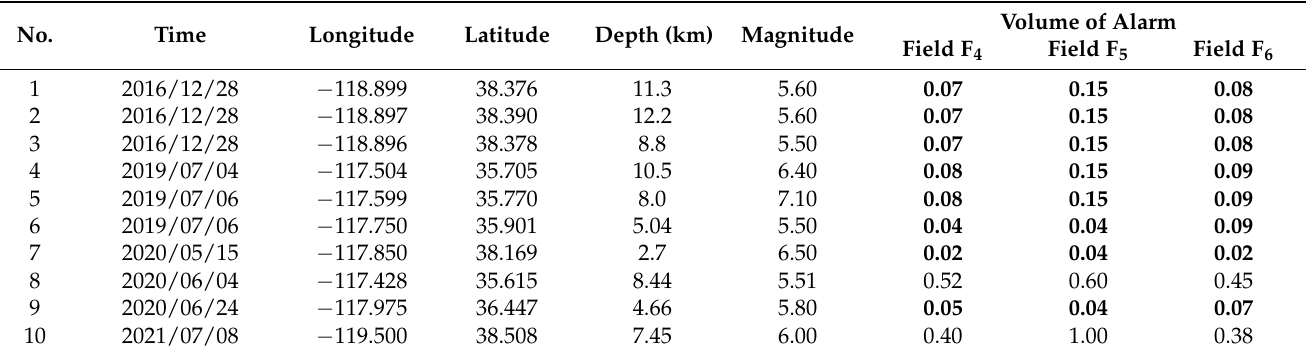
Table 1. Results of forecasting target earthquakes by spatiotemporal fields of increase in time of strain invariants F 4 , F 5 and F 6